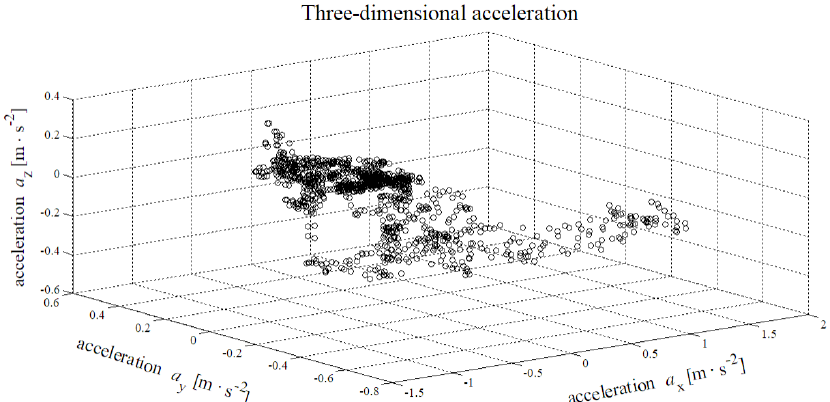
Figure 12. Three-dimensional acceleration synthesis diagram of the electromagnetic suspension